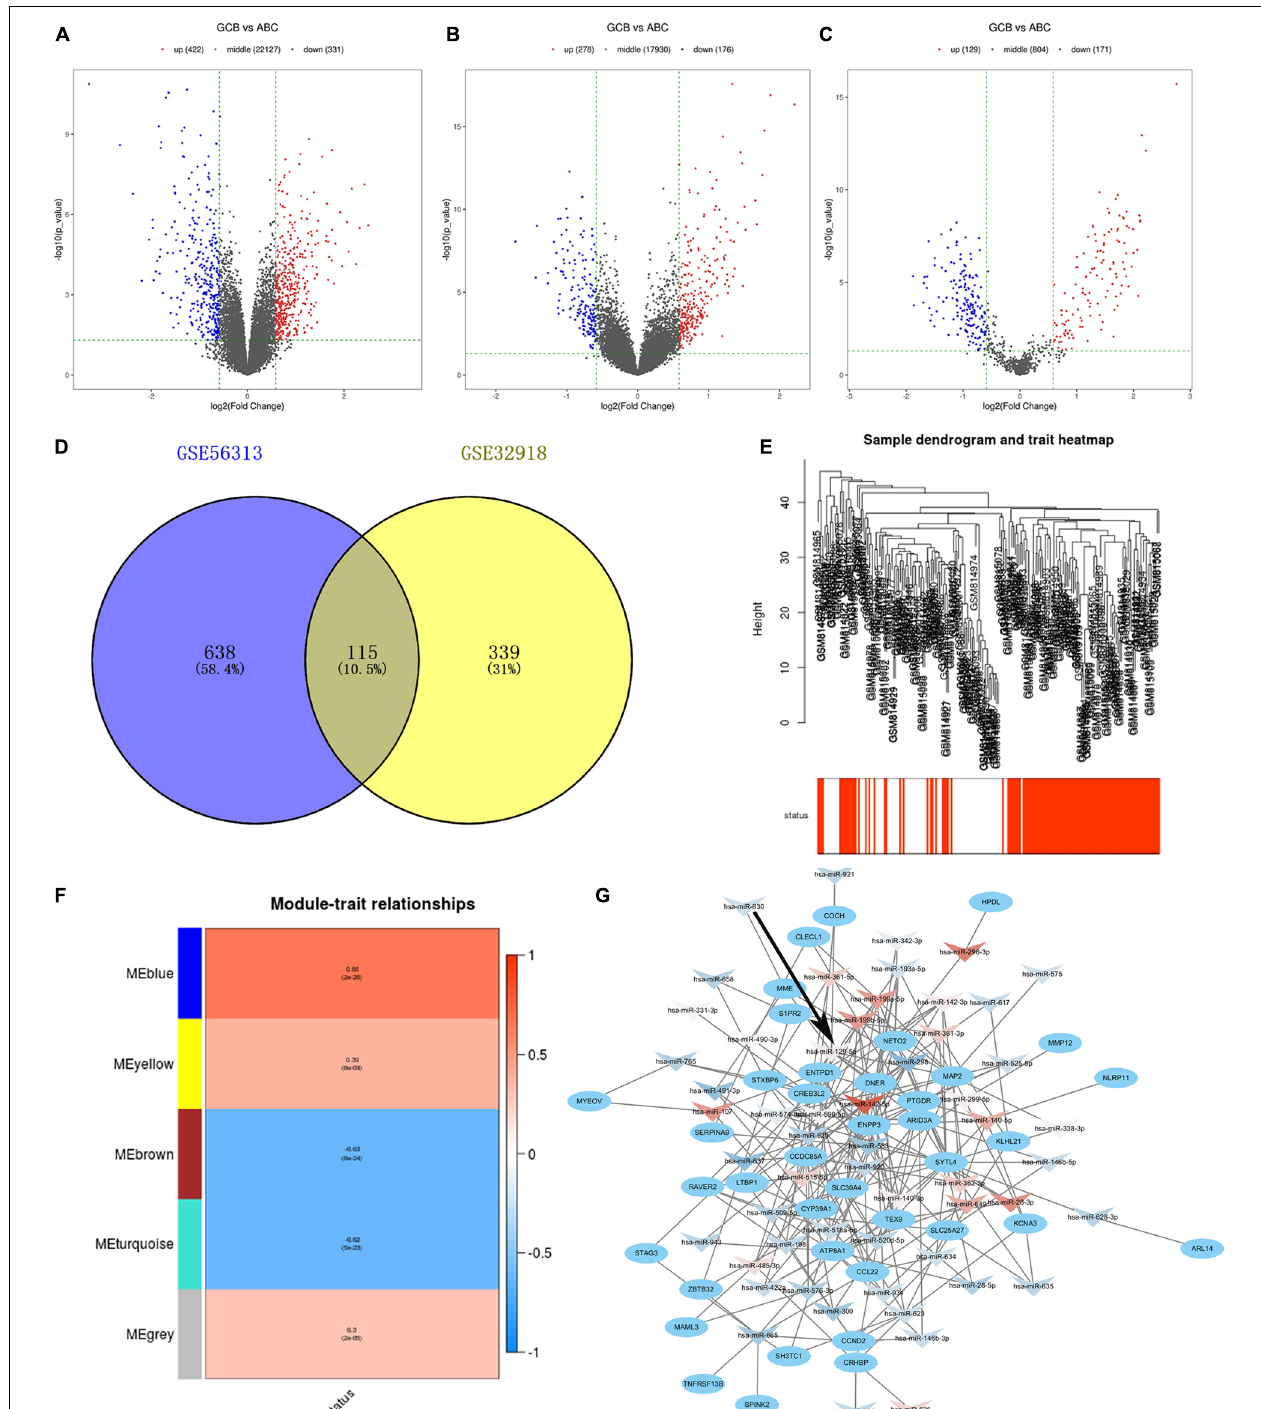
FIGURE 1 | (A–C) Volcano plots show gene expression in the GSE56313, GSE32918, and GSE15250 datasets. Red and blue symbols indicate genes that were significantly up- and downregulated, respectively. (D) Venn diagrams showing the number of common DEGs between GSE56313 and GSE32918. (E) A hierarchical clustering dendrogram is used to arrange DLBCL samples based on GSE32918, with survival outcomes shown at the bottom. (F) A module-trait relationship matrix is shown with rows and columns corresponding to survival statue and the module eigengenes, and the correlation and p -values are represented in a every box. (G) Regulatory network of miRNA-target mRNA pairs in modular intersection genes. The network contained 56 differentially expressed miRNAs (arrow triangle) and 39 target mRNAs (oval). Red and blue arrow triangles indicate genes that were significantly up- and downregulated, respectively, in the GCB subtype.